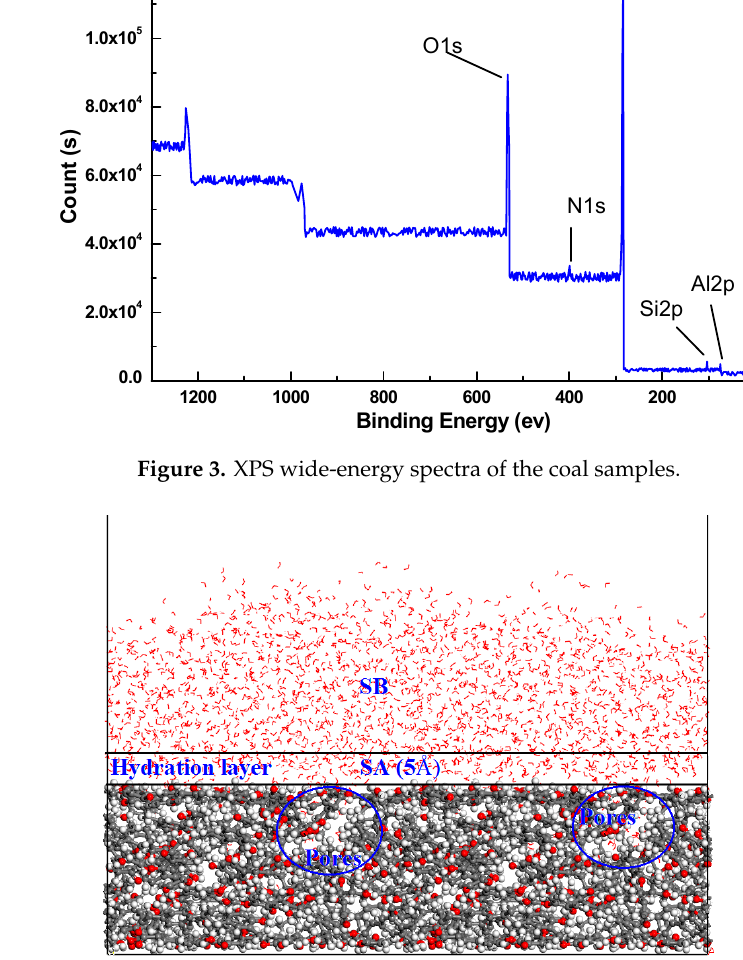
Figure 5. Relative concentration distribution (RCD) of water molecules in the CW system.